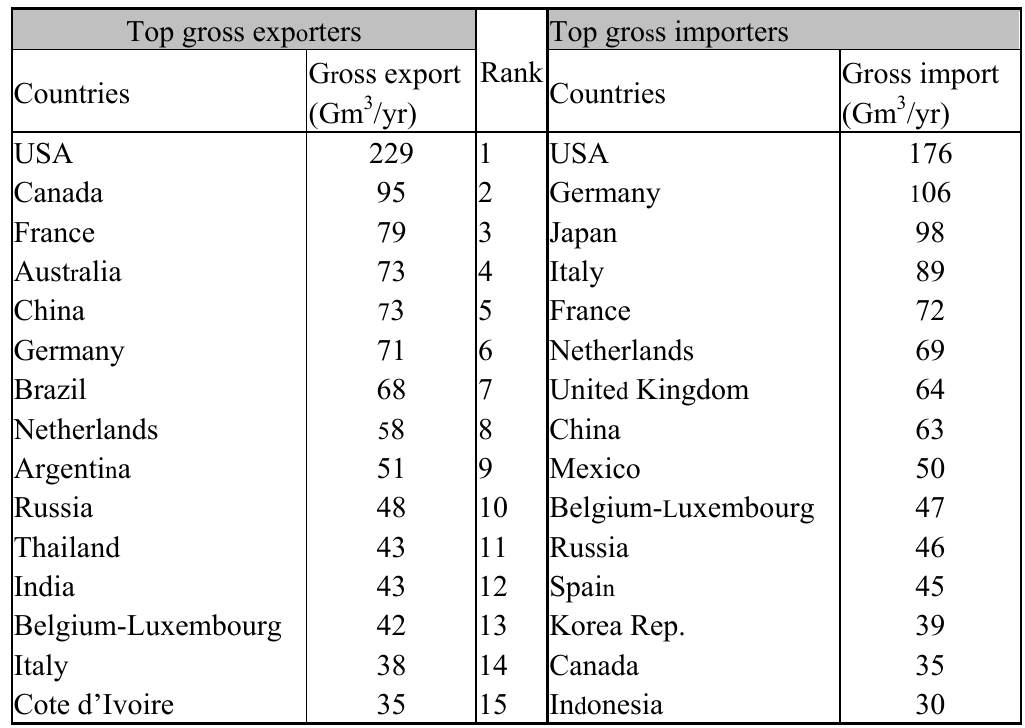
Table 4a. Top-15 of gross virtual water exporters and top-15 of gross virtual water importers for the period: 1997–2001 [Source: Hoekstra, A.Y.; Chapagain, A.K. Globalization of water: Sharing the planet's freshwater resources: Blackwell Publishing, Oxford, UK, 2008].